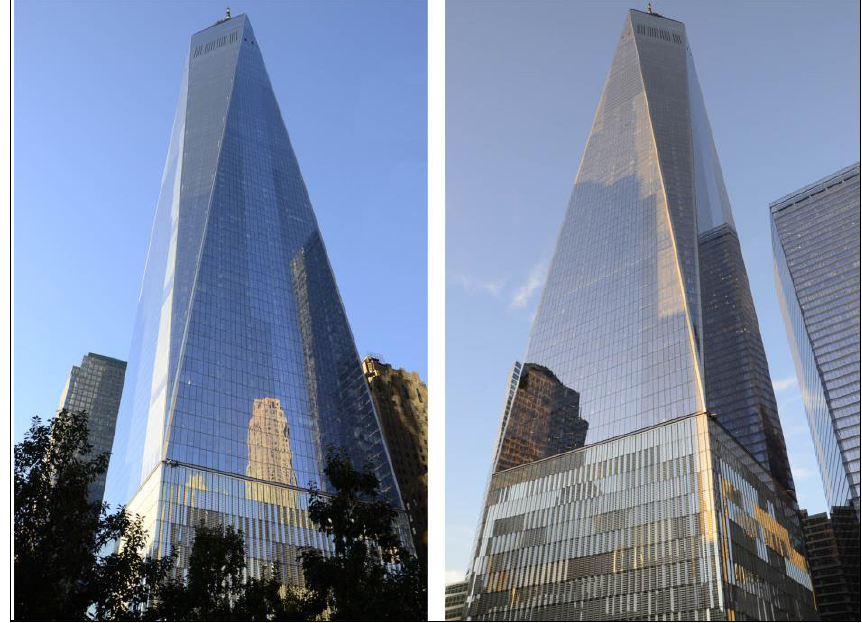
Figure 21. One World Trade Center (photograph by authors). The base of the skyscraper is designed on a square plan (61 m), whereas the structure is a square